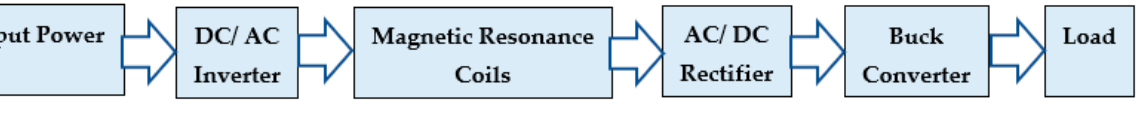
Figure 11. Open-loop WPT block diagram.